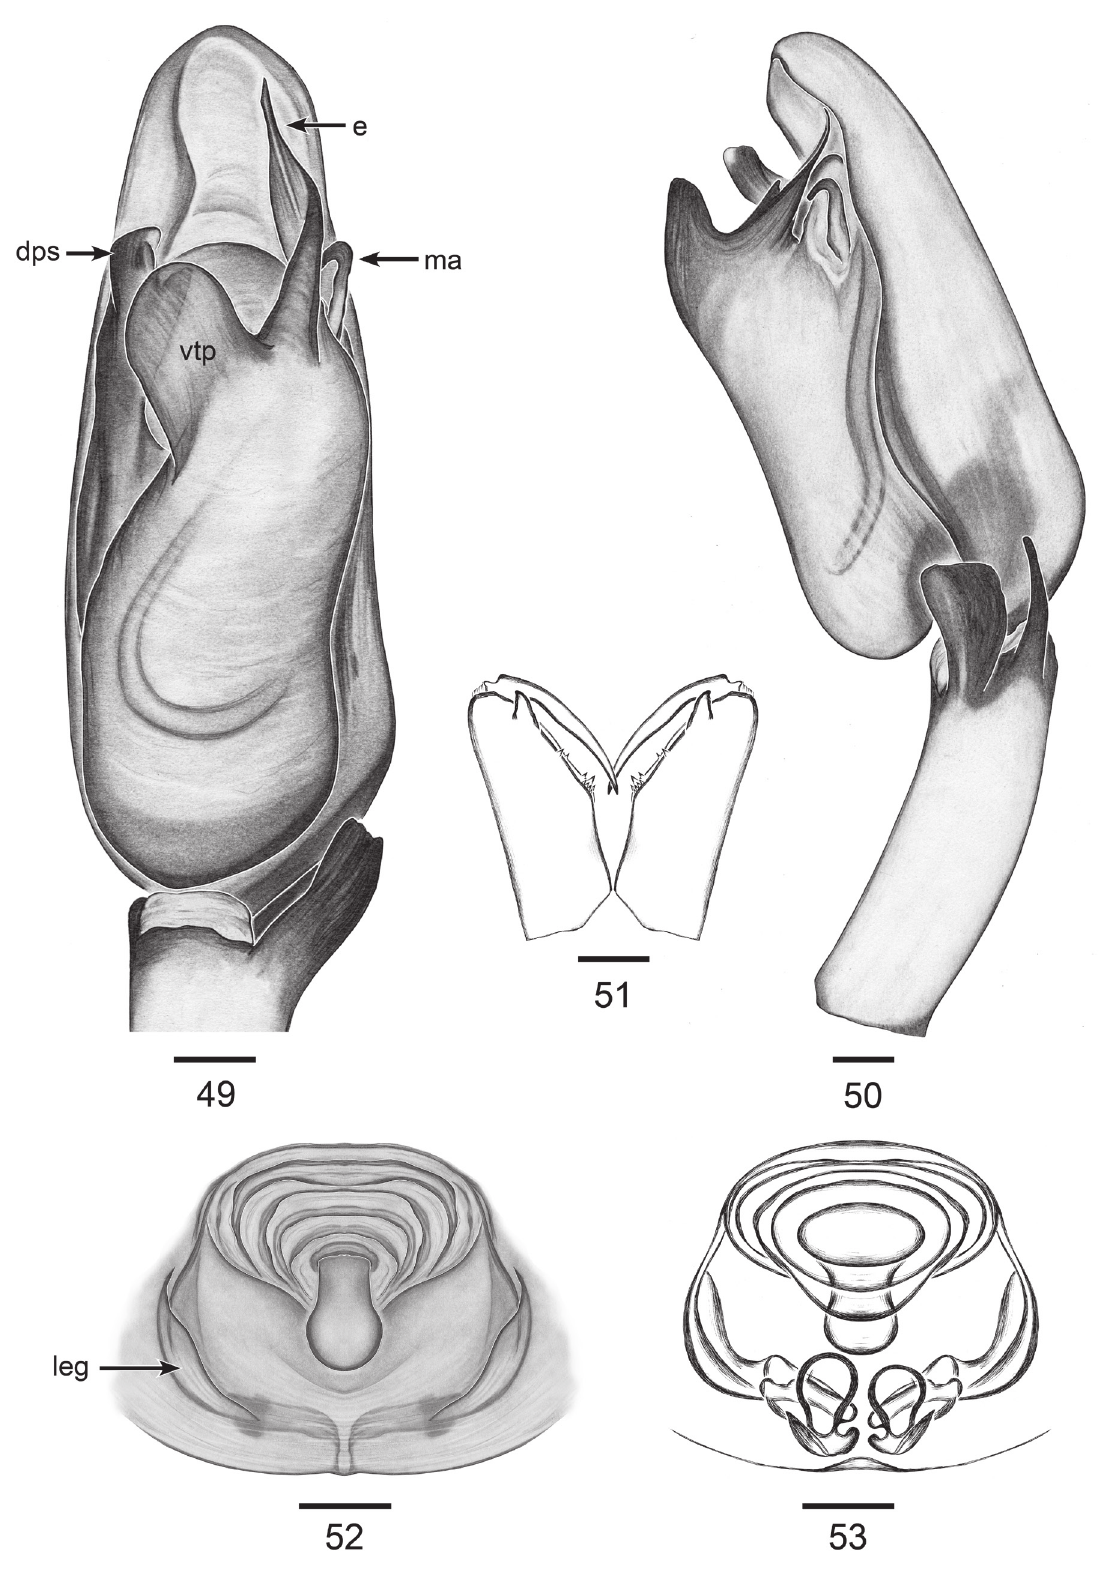
Figs 49–53. Patrera witsu sp. nov. 49 . ♂, palp, ventral view. 50 . ♂, palp, retrolateral view. 51 . ♂, chelicerae, posterior view. 52 . ♀, epigynum, ventral view. 53 . ♀, internal genitalia, dorsal view. Scale bars: 49–50, 52–53 = 0.1 mm; 51 = 0.5